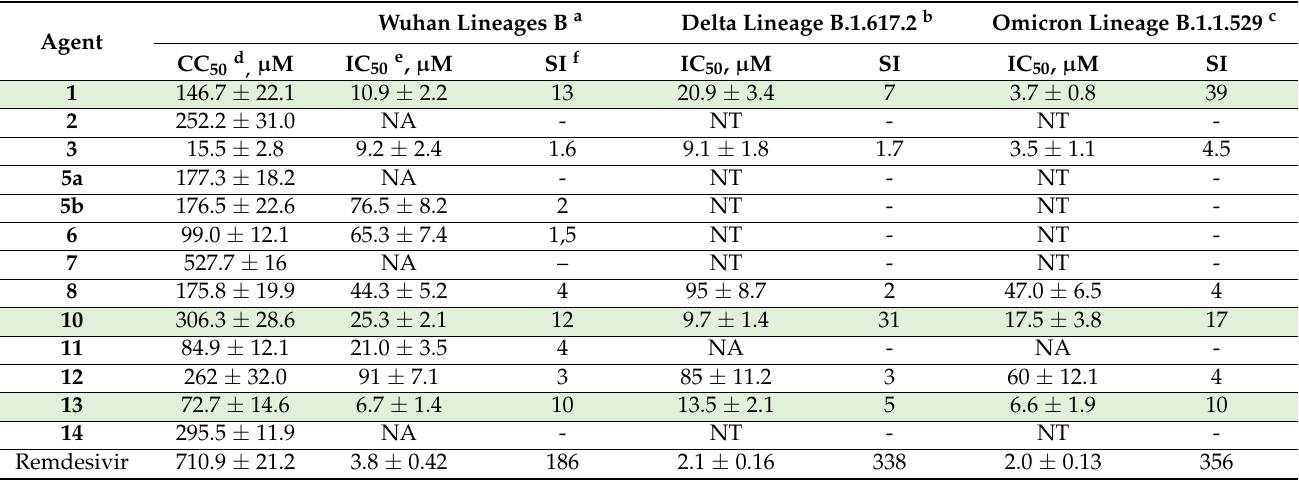
Table 1. Results of study of antiviral activity of compounds against SARS-CoV-2